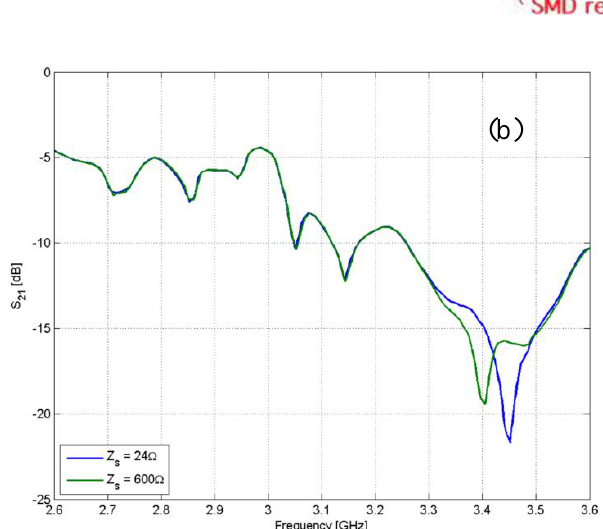
Figure 11. ( a ) Photo of a five-bit chipless tag equipped with a thermistor and ( b ) measured | S 21 | response of a five-bit chipless tag equipped with a thermistor.